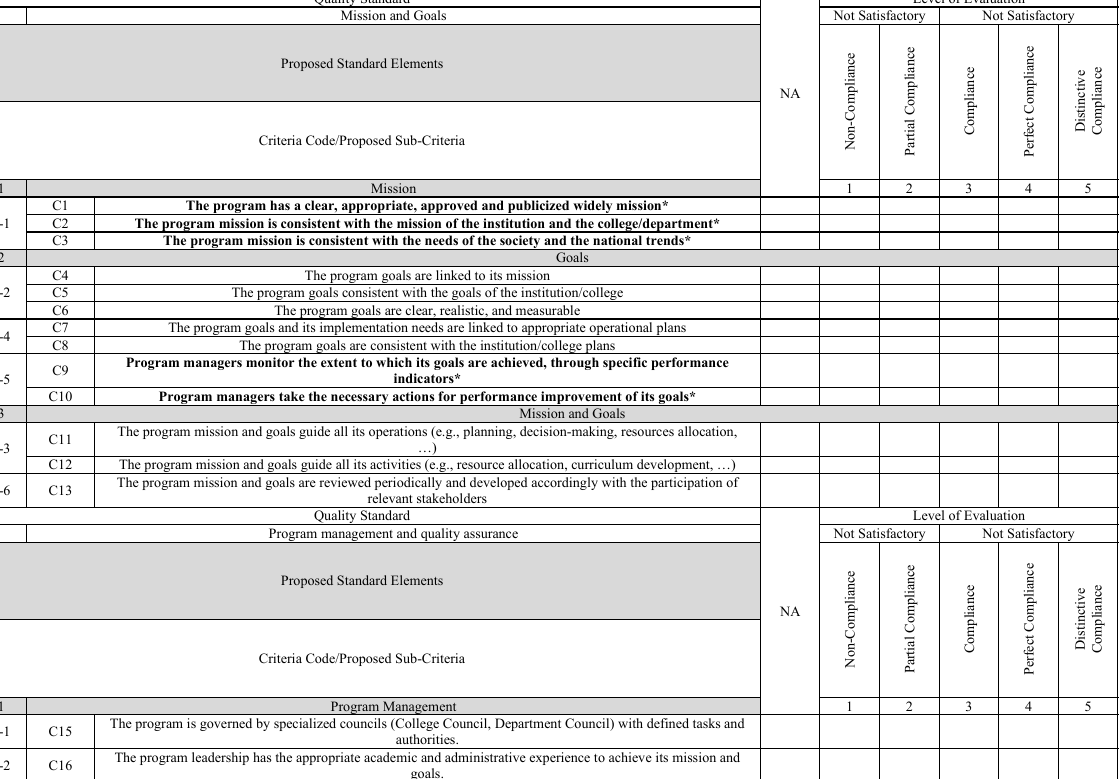
The proposed self-evaluation table for high educational programs Quality